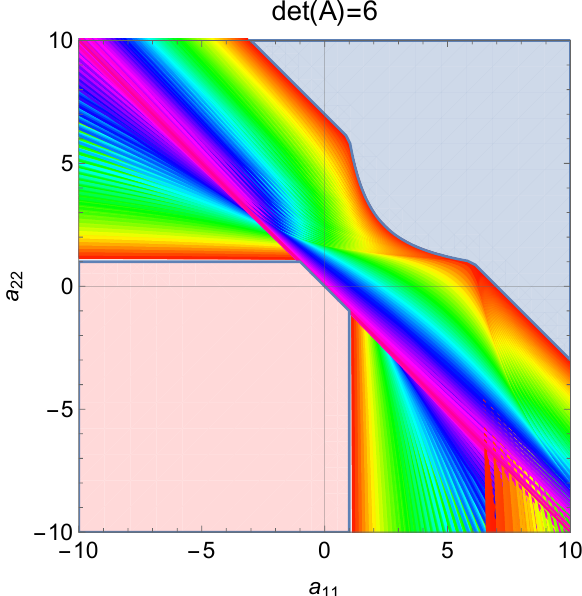
(cid:110) (cid:111) k , k = 1,40 , i = 1,2 40